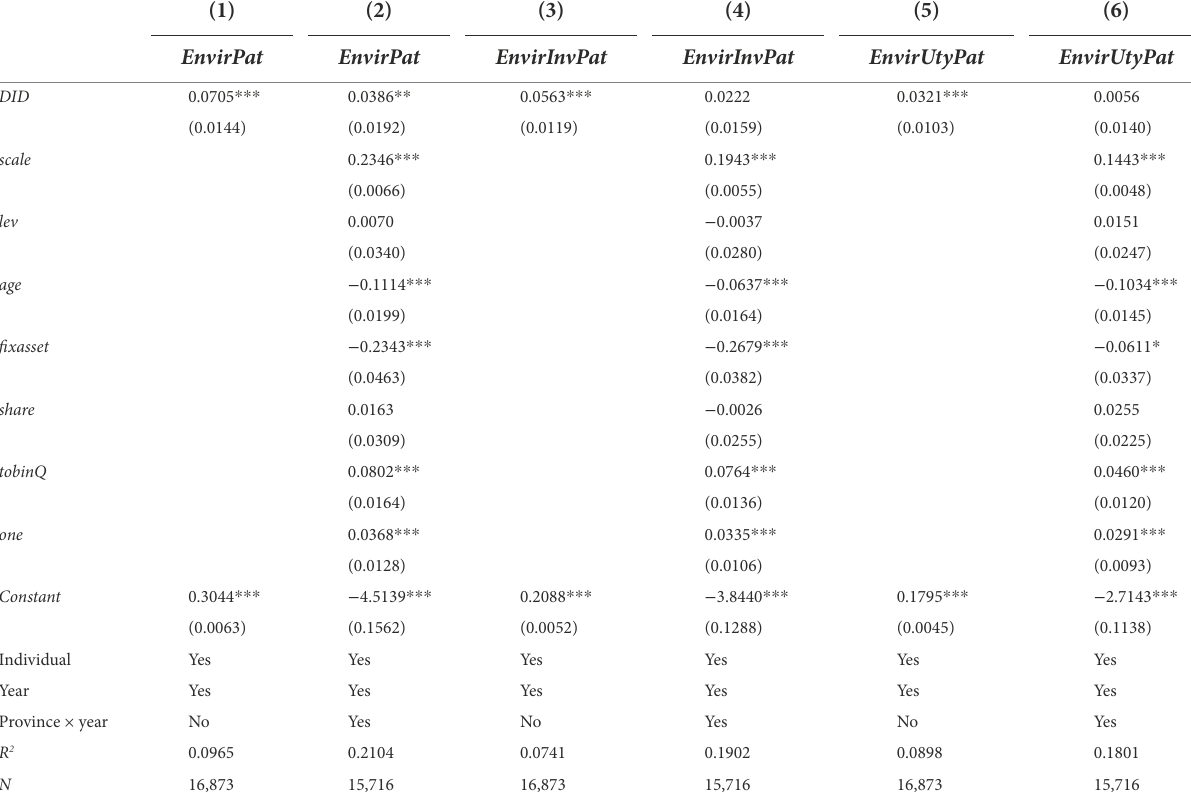
TABLE 2 The impact of the energy saving and emission reduction fiscal policy on corporate green technology